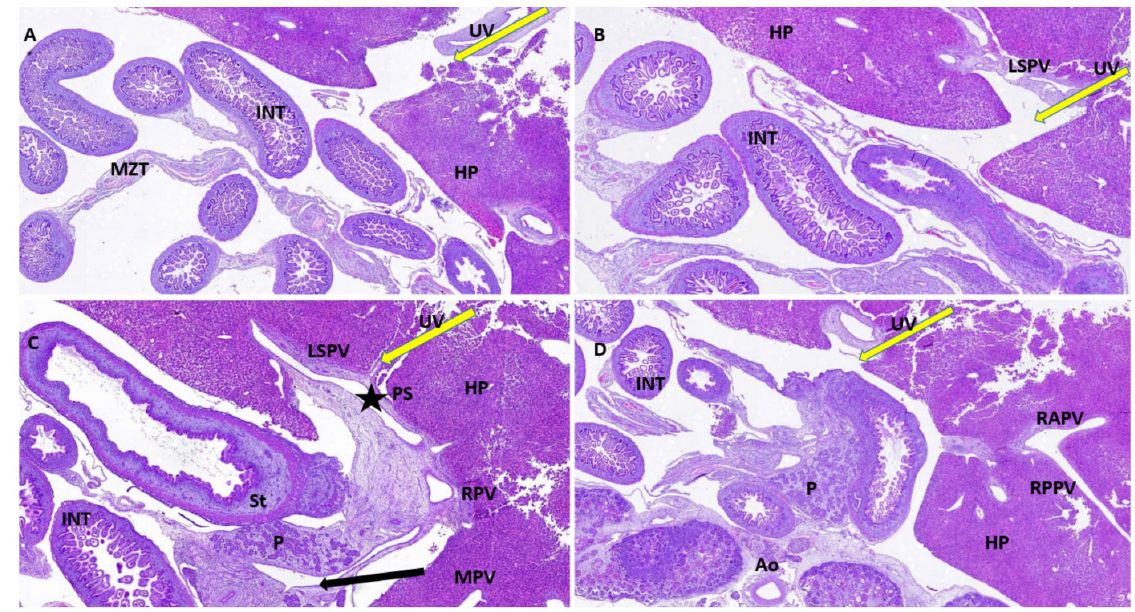
Figure 6. Histological appearance of the FT liver with normal PVS. ( A ): Histopathological aspect of FT fetal liver. It is observed how UV enters the hepatic structure (yellow arrow) and reaches its visceral surface near the intestinal loops; ( B ): LSPV is identified in the structure of the liver parenchyma, toward its posterior face, in the vicinity of the intestinal loops and the stomach; ( C ): the L-shaped umbilical vein confluence and the PS (star) is observed in the structure of the liver parenchyma; ( D ): the two main branches of the RPV are identified as RAPV and RPPV. Classic hematoxylin-eosin staining, × 100. UV: umbilical vein, HP: hepatic parenchyma, INT: intestines, MZT: mesentery, LSPV: left superior portal vein, PS: portal sinus, RPV: right portal vein, MPV: main portal vein, P: pancreas tissue, St: stomach, Ao: aorta, RAPV: right anterior portal vein, RPPV: right posterior portal vein.